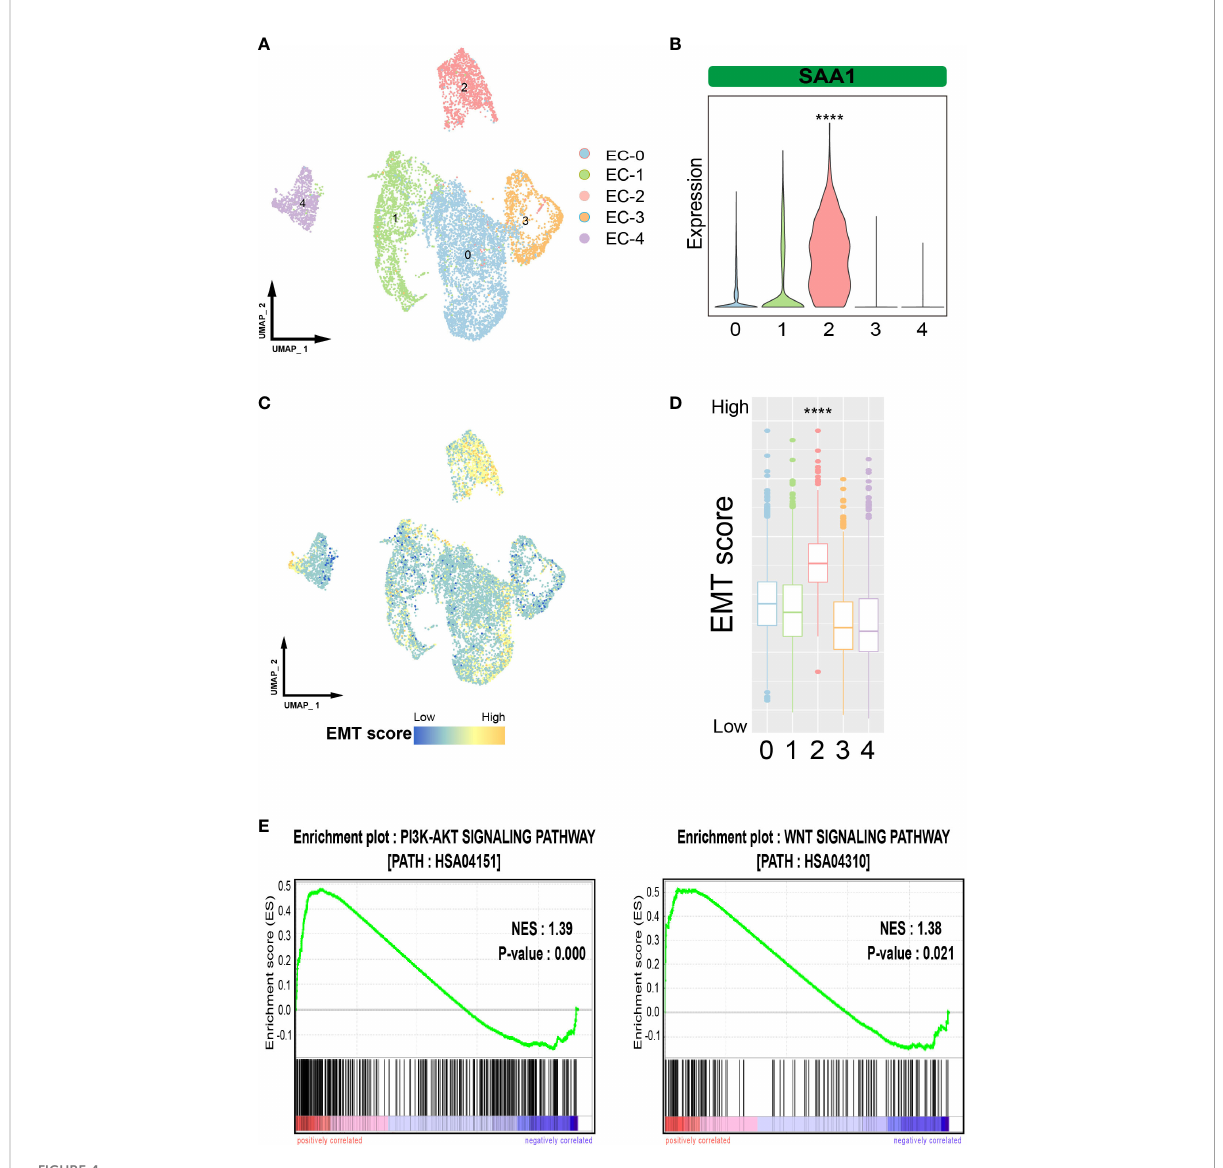
FIGURE 4 Veri fi cation of SAA1+ epithelial cell subpopulations. (A) . UMAP plot showing the subpopulations of epithelial cells in the veri fi cation data. (B) . Violin plot showing the expression of SAA1 in different epithelial subpopulations in the veri fi cation data. (C) . UMAP plot showing EMT levels of epithelial cells in the veri fi cation data. (D) . Box plot showing the EMT levels of epithelial cells in the veri fi cation data. (E) . GSEA showing that the pathways activated in SAA1+ cell subpopulation. The symbol **** represent p-values less than